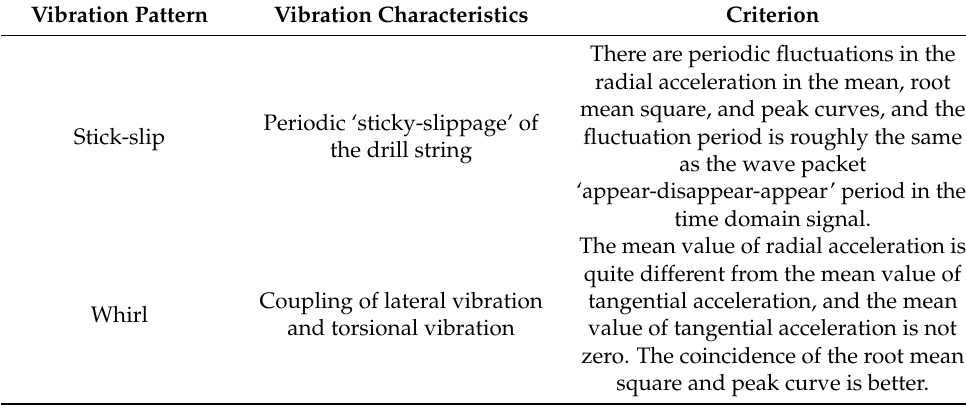
Table 5. Drill string vibration modes and criteria. Vibration